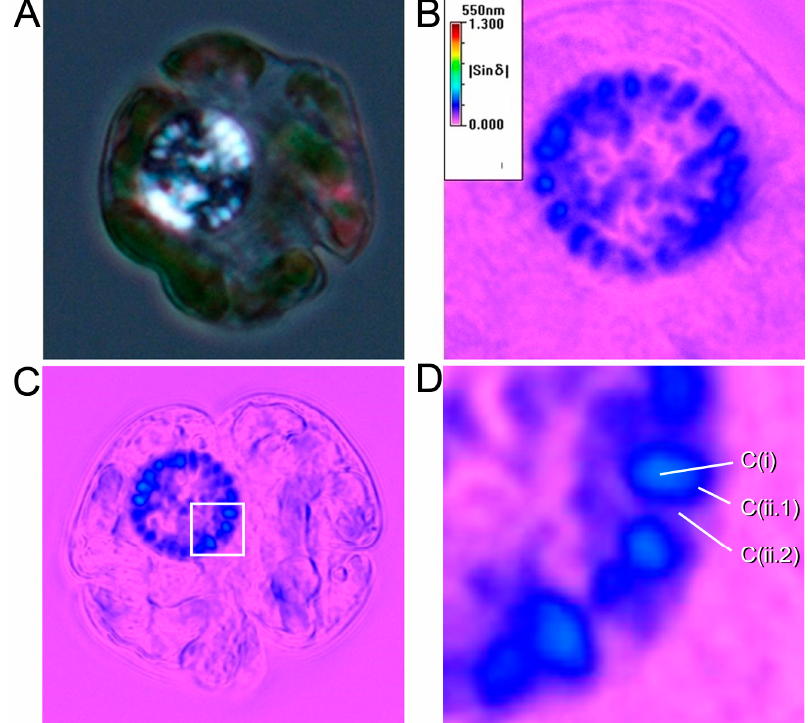
Figure 1. Birefringence imaging of live dinoflagellate cells. ( a ) Birefringence image of a live Karenia brevis cell. This cell was in the G 1 phase of the cell cycle. Some focused LCCs exhibited inner and outer cores. They were observed under cross-polar with Olympus BX-51. A Karenia brevis cell has a flattened shape and is approximately 35-50 µm in width. The black and white birefringence within a LCC was indicative of opposite anisotropic orientations in the inner core and outer core compartments (b,c) and shows retardance images of a live Karenia brevis cell. Retardance, the intensity of the integrated birefringence, was quantitatively imaged through a semi-automatic polarizing light microscopic system, as previously described and displayed in pseudo color [2,11] . The Metripol polarizing light microscope system (Oxford Cryosystem) employed a motorized rotating polarizer and a fixed circular analyzer with Olympus BX-51 [12,13] . Higher retardances were observed at the inner cores (C(i), light blue), when compared to surface compartments (C(ii.1) + PCL C(ii.2), dark blue) in some LCCs. Each LCC in focus was individually surrounded by a third region with low or no detectable retardance, representing C(ii.2) (images by Mike Bennett).